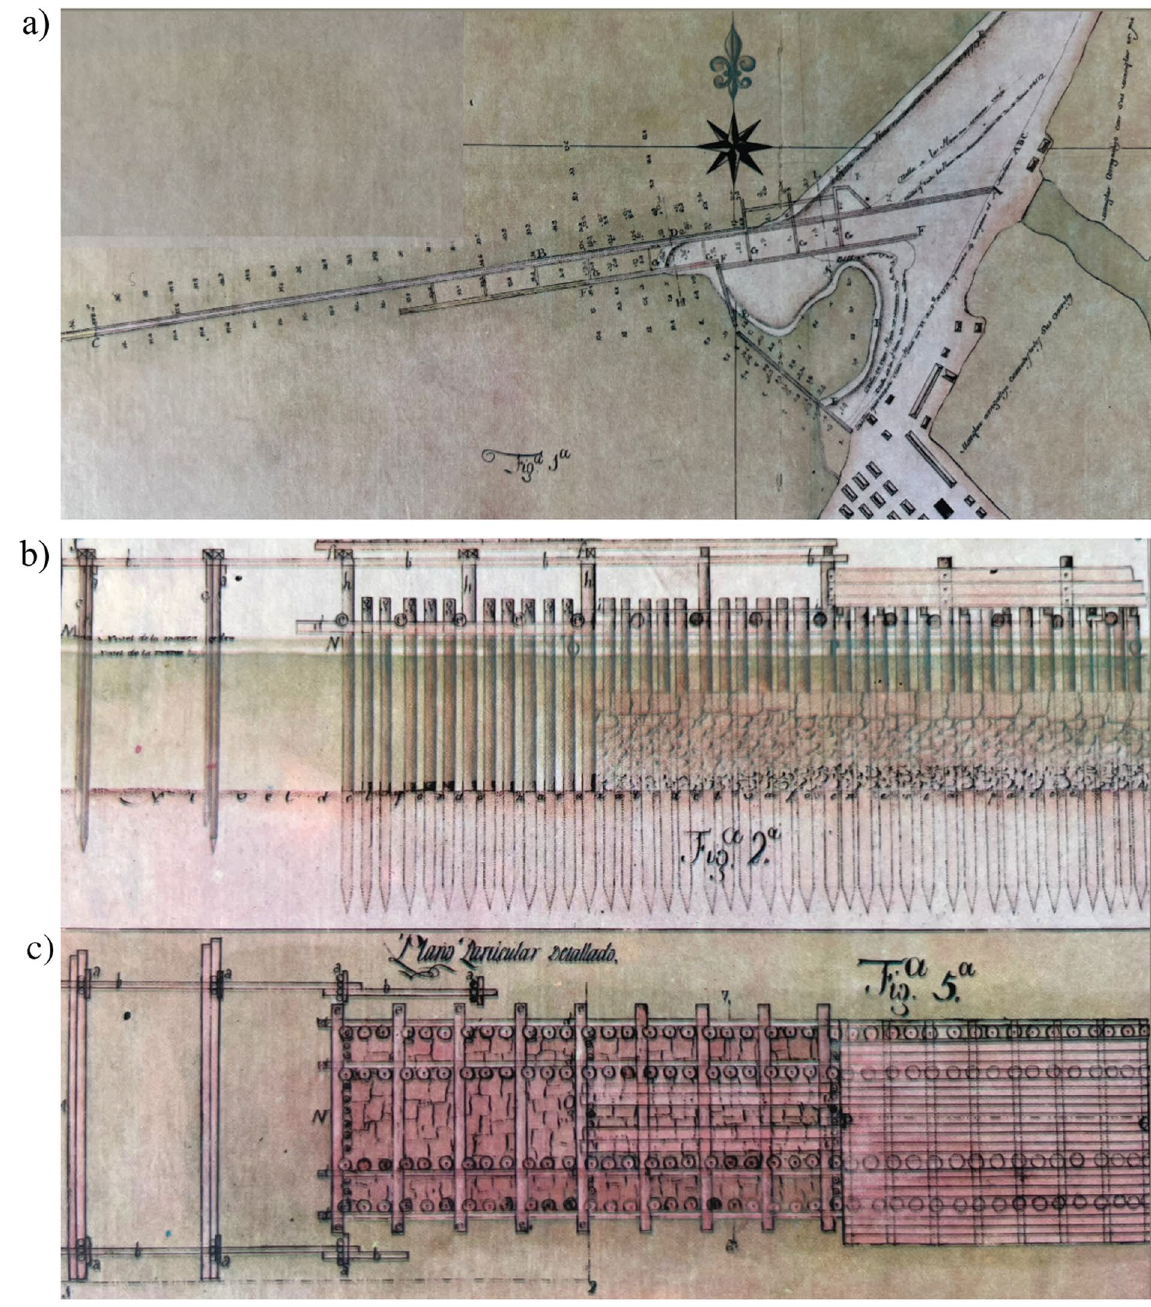
Fig. 2 Original drawings of Antonio de Arévalo from 1773. Taken and adapted form (Zapatero Lopez and García Baquero 1980), a Plan of the Bocagrande breakwater design; b Breakwater longitudinal profile; c Pile plan